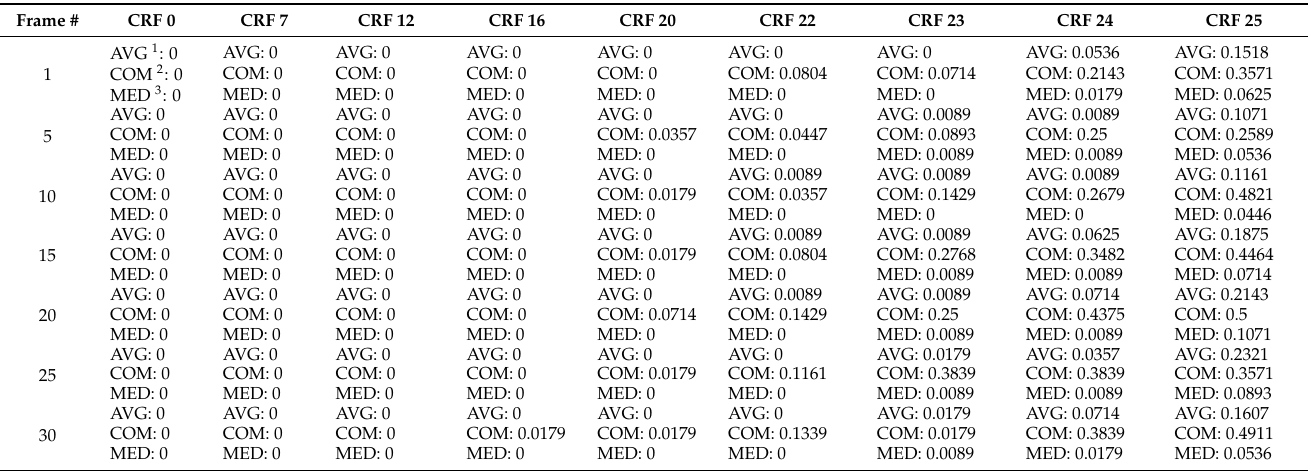
Table 9. Algorithm performance results for a 480 × 640 video fragment encoded with a 128 × 128 encoder trained for CRF = 24 for changes in CRF coefficient in the form of a BER de- pending on the watermark reading variant.